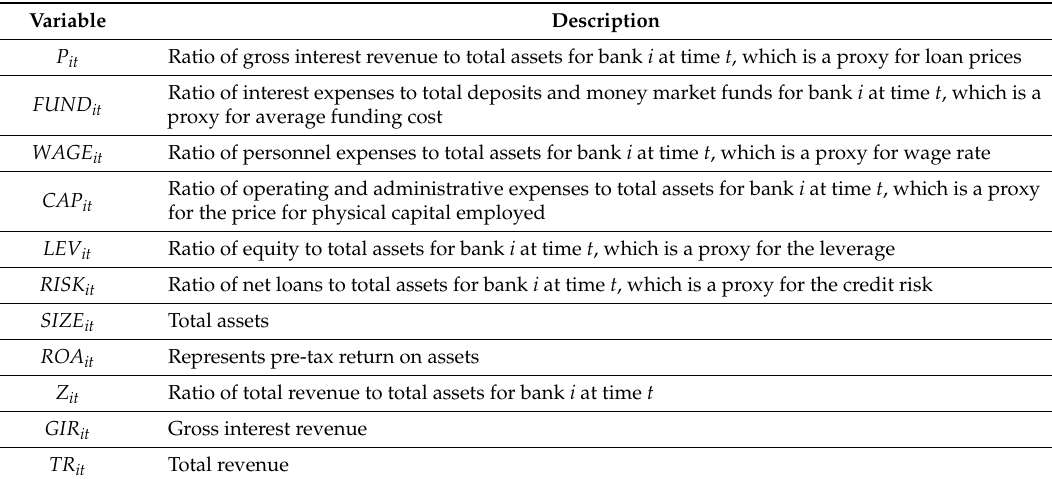
Table 1. Variables and their